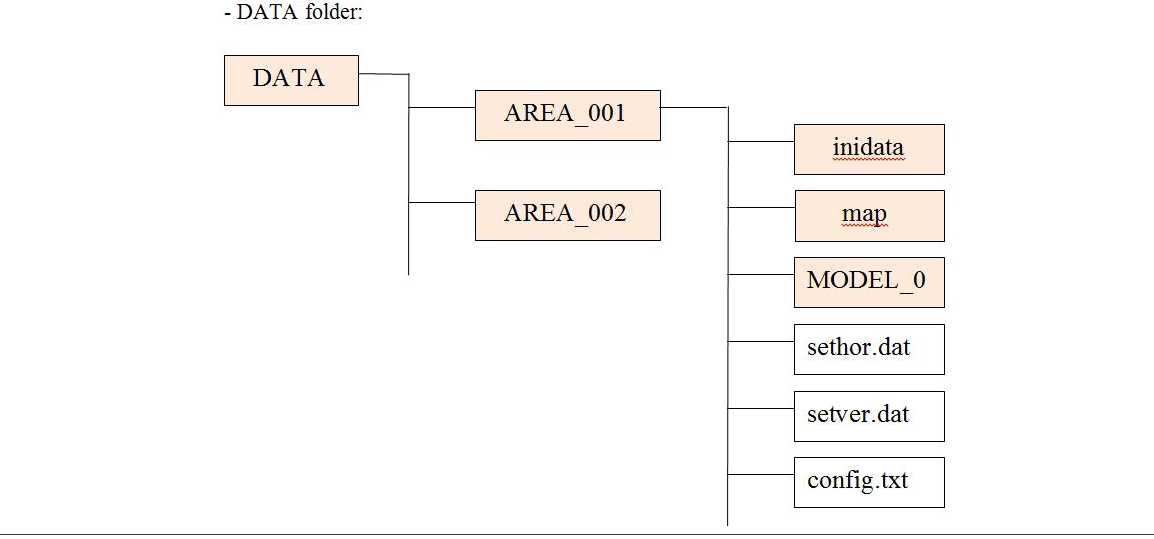
Figure A.2. Directory scheme of the DATA